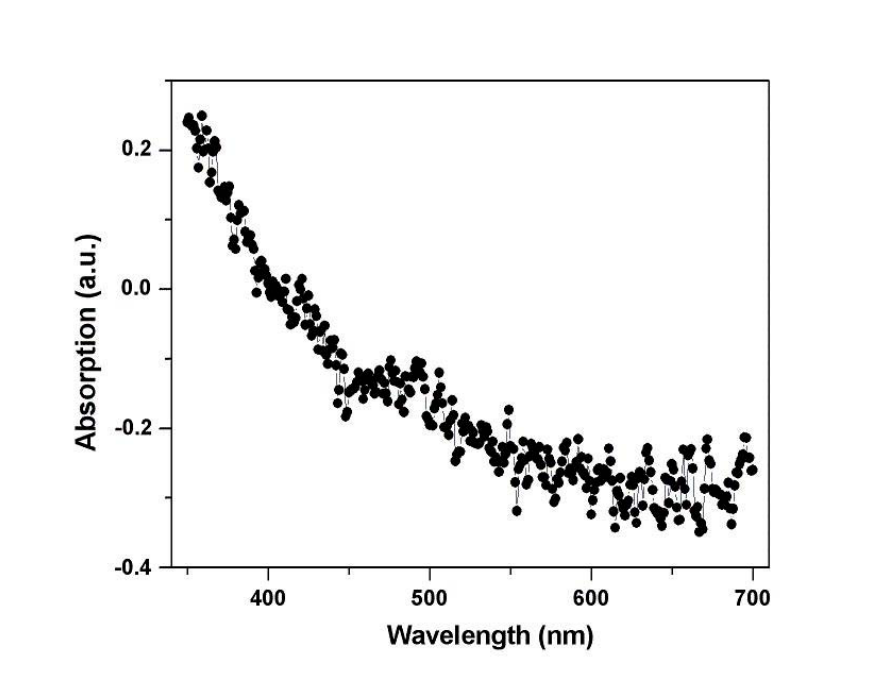
Figure 9. Absorption spectrum obtained for sample 1 with the electret microphone. Negatives values appear because of problems in the normalization procedure.